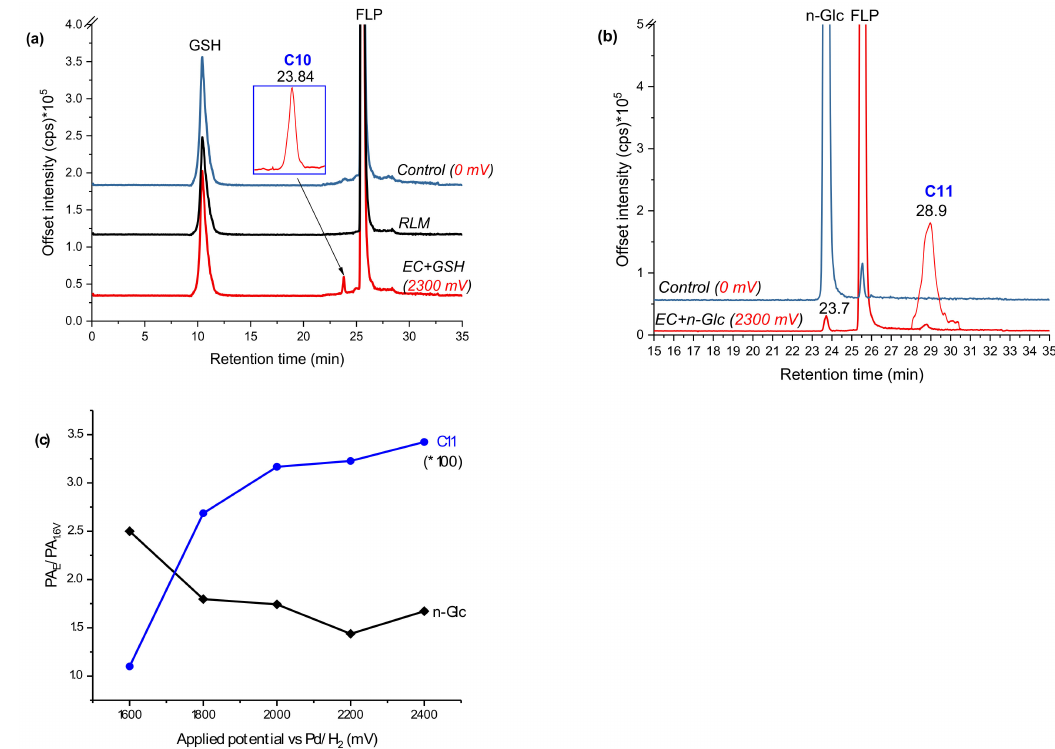
Figure 7. EIC of FLP oxidative products effluent incubated with GSH ( a ) or n-Glc ( b ), and peak area ratios of selected conjugates shown at different applied potentials ( c ), measured by LC-MS/MS on (+) ESI.